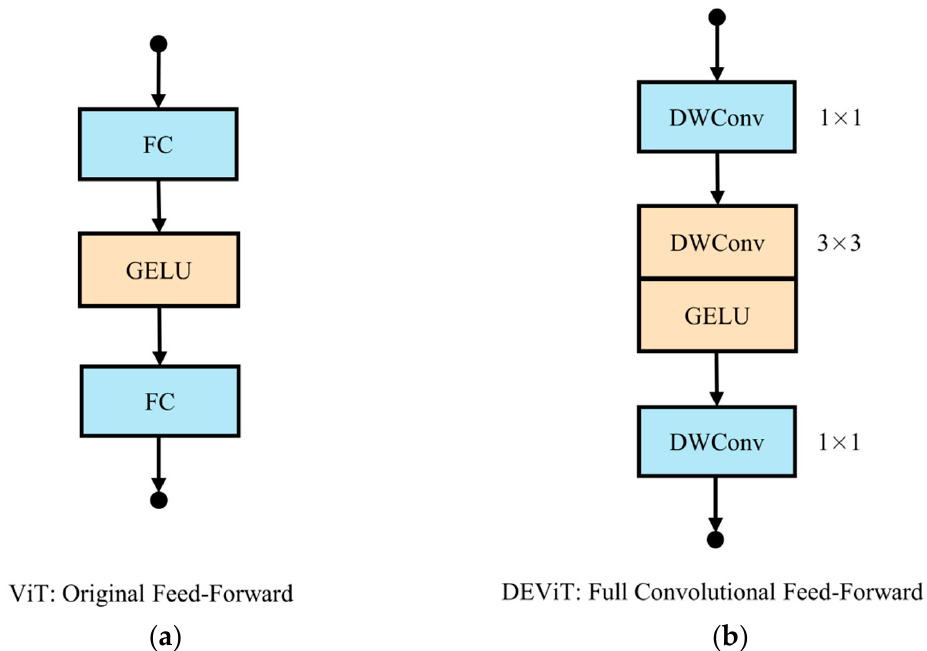
Figure 5. Comparison of FFN and FCFN: ( a ) the vanilla FFN of a vision transformer; ( b ) the FCFN of DEViT.